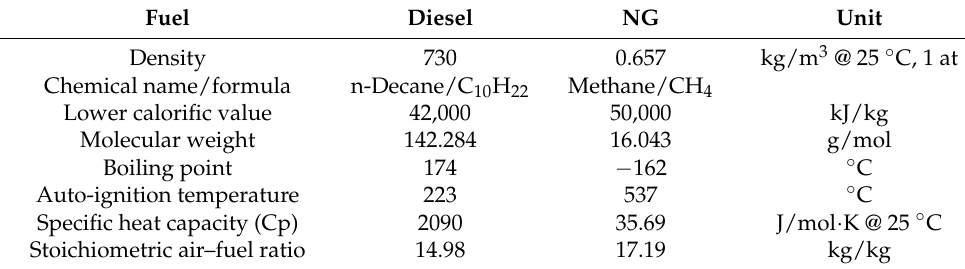
Table 4. Fuel properties [33,35,36].